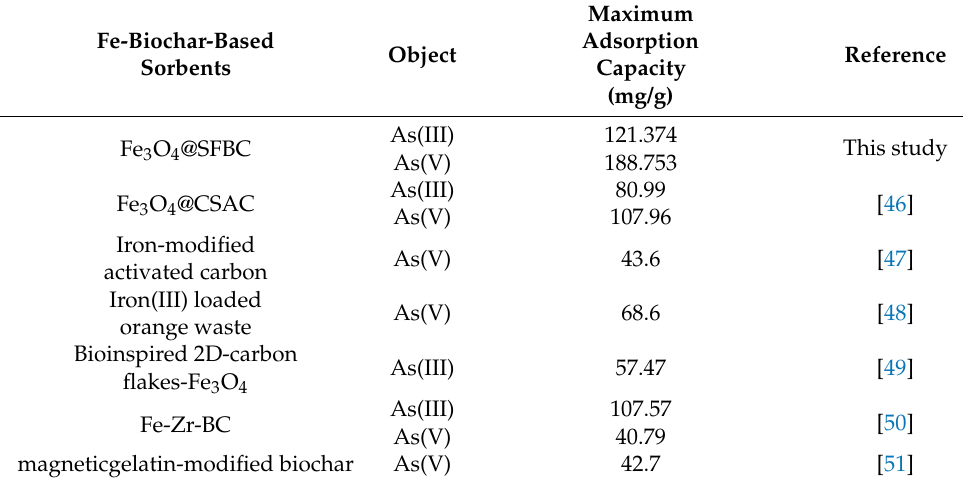
Table 3. Various adsorbent materials’ Langmuir adsorption